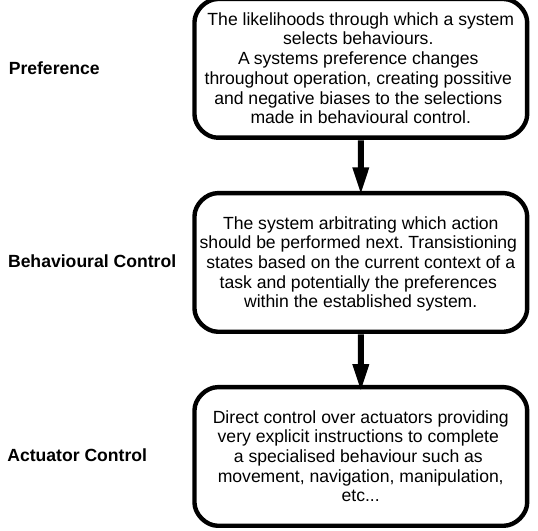
Figure 1. Behavioural hierarchy for those behaviours investigated within this